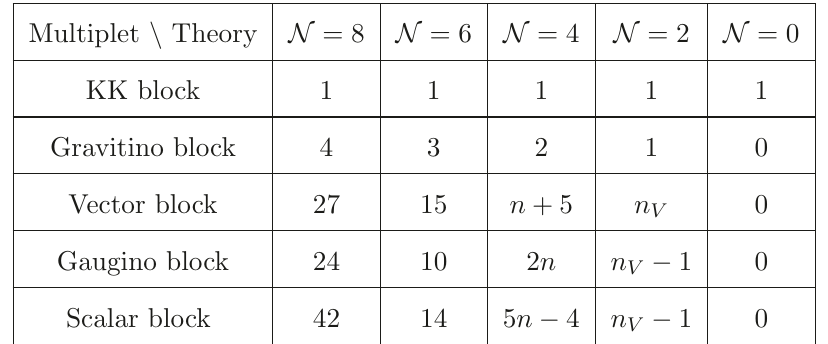
Table 4 . The degeneracy of multiplets in the spectrum of quadratic fluctuations around the KK black hole embedded in various theories. For = 4, the integer n is the number of = 4 matter N N multiplets. For = 2, the integer n V refers to the ST ( n V 1) model. N − terms of the same simple blocks that appear in = 8 supergravity. For these truncations N the entire dependence on the theory is encoded in the degeneracy of each type of